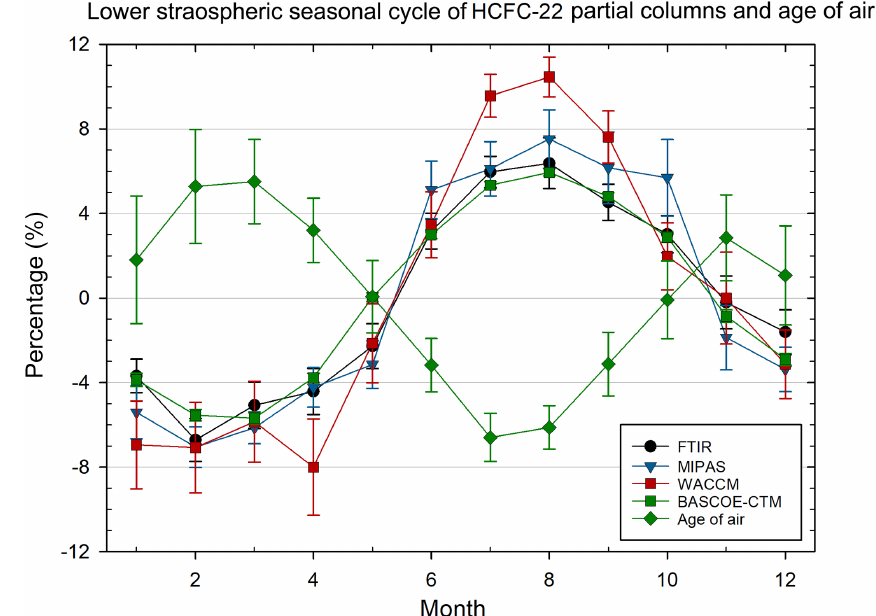
Figure 5. Seasonal cycle of HCFC-22 columns (see Sect. 4.3 for method) in the lower stratosphere (11.21–30km) based on measurements and model outputs (2005–2012). MIPAS measurements are at a maximum distance of 500km from the JFJ station. Vertical bars depict the 2 σ standard error of the means. The age of air simulation is performed by BASCOE-CTM from the ERA-Interim reanalysis. The peak-to-peak amplitude of the age of air cycle is 0.37 years and the mean age of air is 2.96 years.